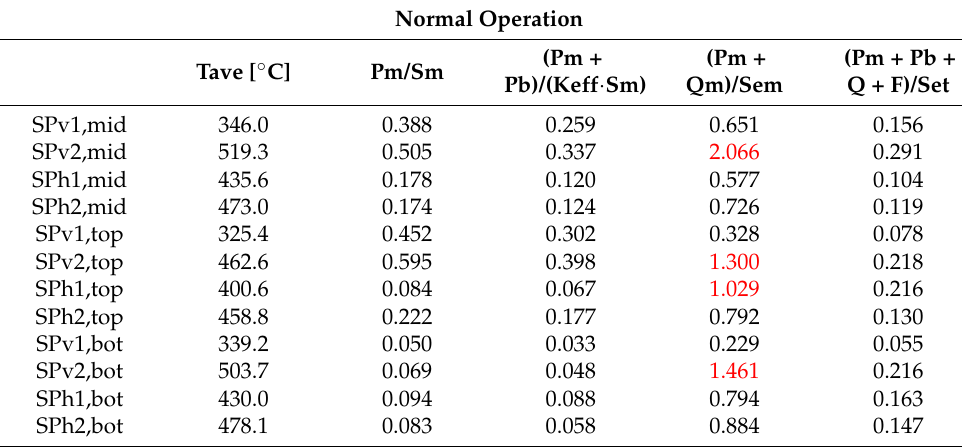
Table 6. Verification of RCC-MRx criteria under NO loading scenario.